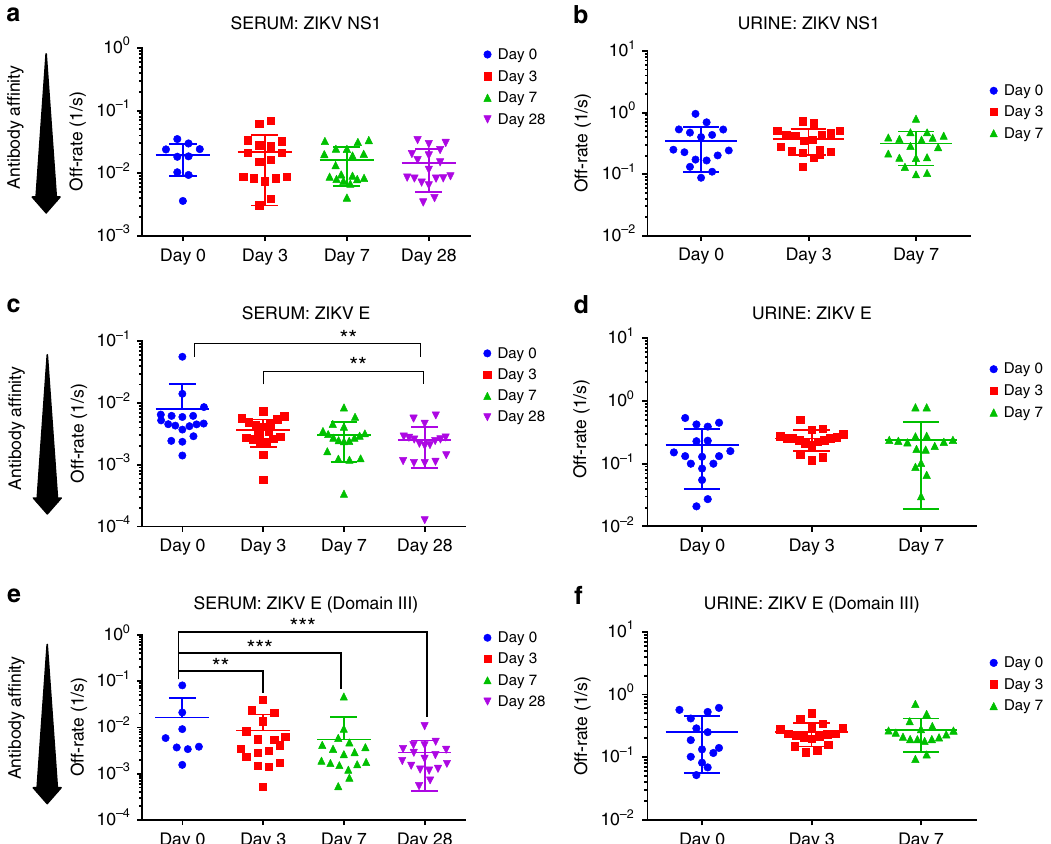
Fig. 6 Antibody af fi nity maturation in Zika virus (ZIKV)-infected serum and urine to NS1, E, E-dIII. SPR analysis of individual sera ( a , c , e ) or urine ( b , d , f ) post-ZIKV infection was performed with puri fi ed recombinant NS1 ( a , b ), ZIKV-E ( c , d ), and ZIKV-E-domain III ( e , f ) proteins to determine the dissociation kinetics (off-rates) at different time points post infection. Antibody off-rate constants that describe the fraction of antibody – antigen complexes decaying per second were determined directly from the serum/urine sample interaction with recombinant and NS1, ZIKV-E, ZIKV-E-domain III proteins using SPR in the dissociation phase as described in Methods. Mean values with standard deviation are shown by bar for each group. Antibody off-rates were not calculated for samples with total antibody binding (Max RU shown in Fig. 5) of <10 at 10-fold dilution and is not shown in fi gure. The statistical signi fi cances between each time point (visit days) were determined using two-tailed paired t -test in GraphPad software. p -Values <0.05 were considered signi fi cant with a 95% con fi dence interval. Statistically signi fi cant with p -values of <0.005 (**), or <0.001 (***) are shown. Source data are provided as